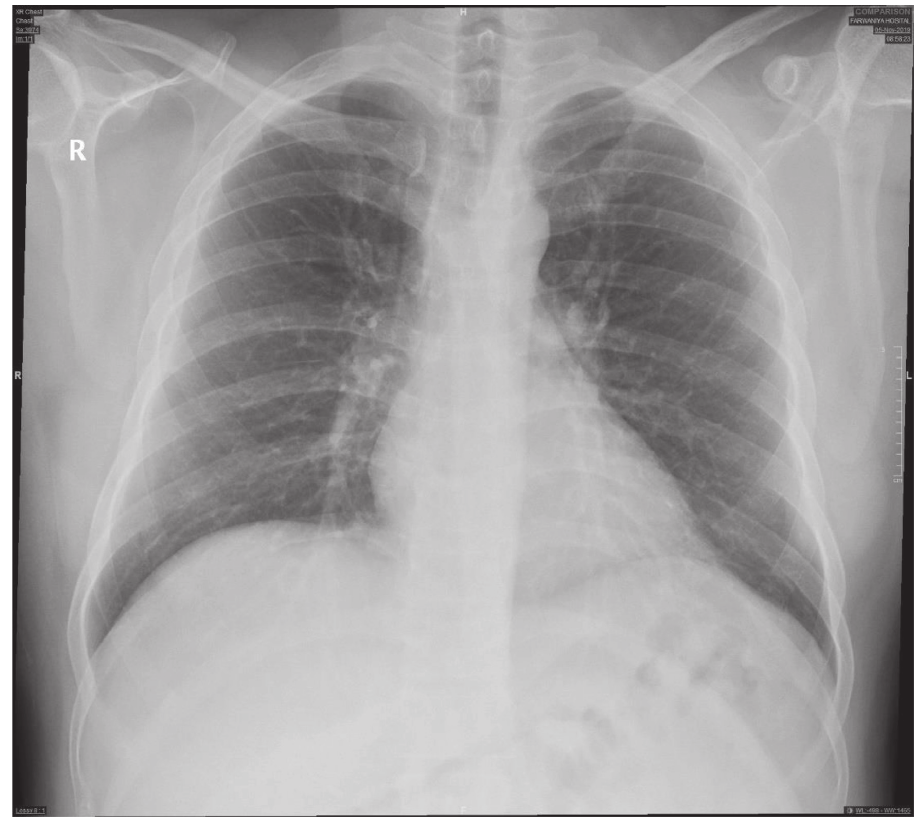
Figure 7: Follow-up chest radiograph showing no evidence of recurrence of